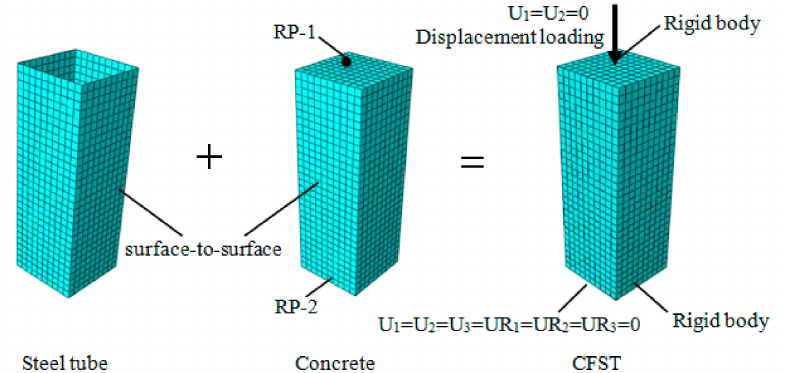
Figure 3. Finite element model meshing and boundary